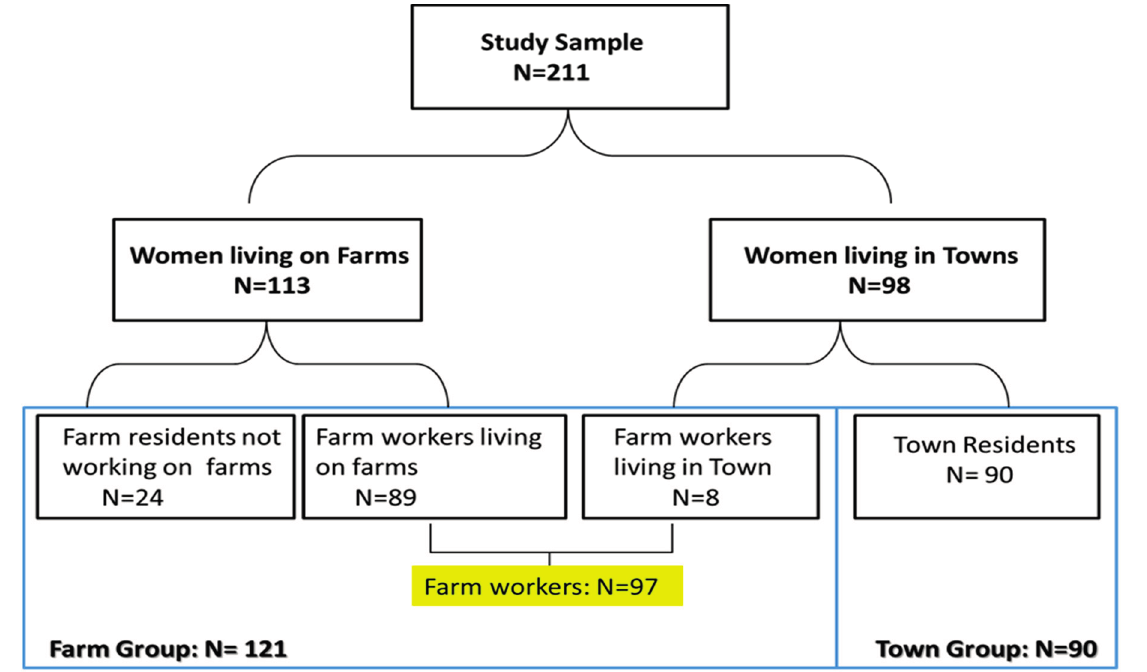
Figure 1. Diagram of sampling and participation in the